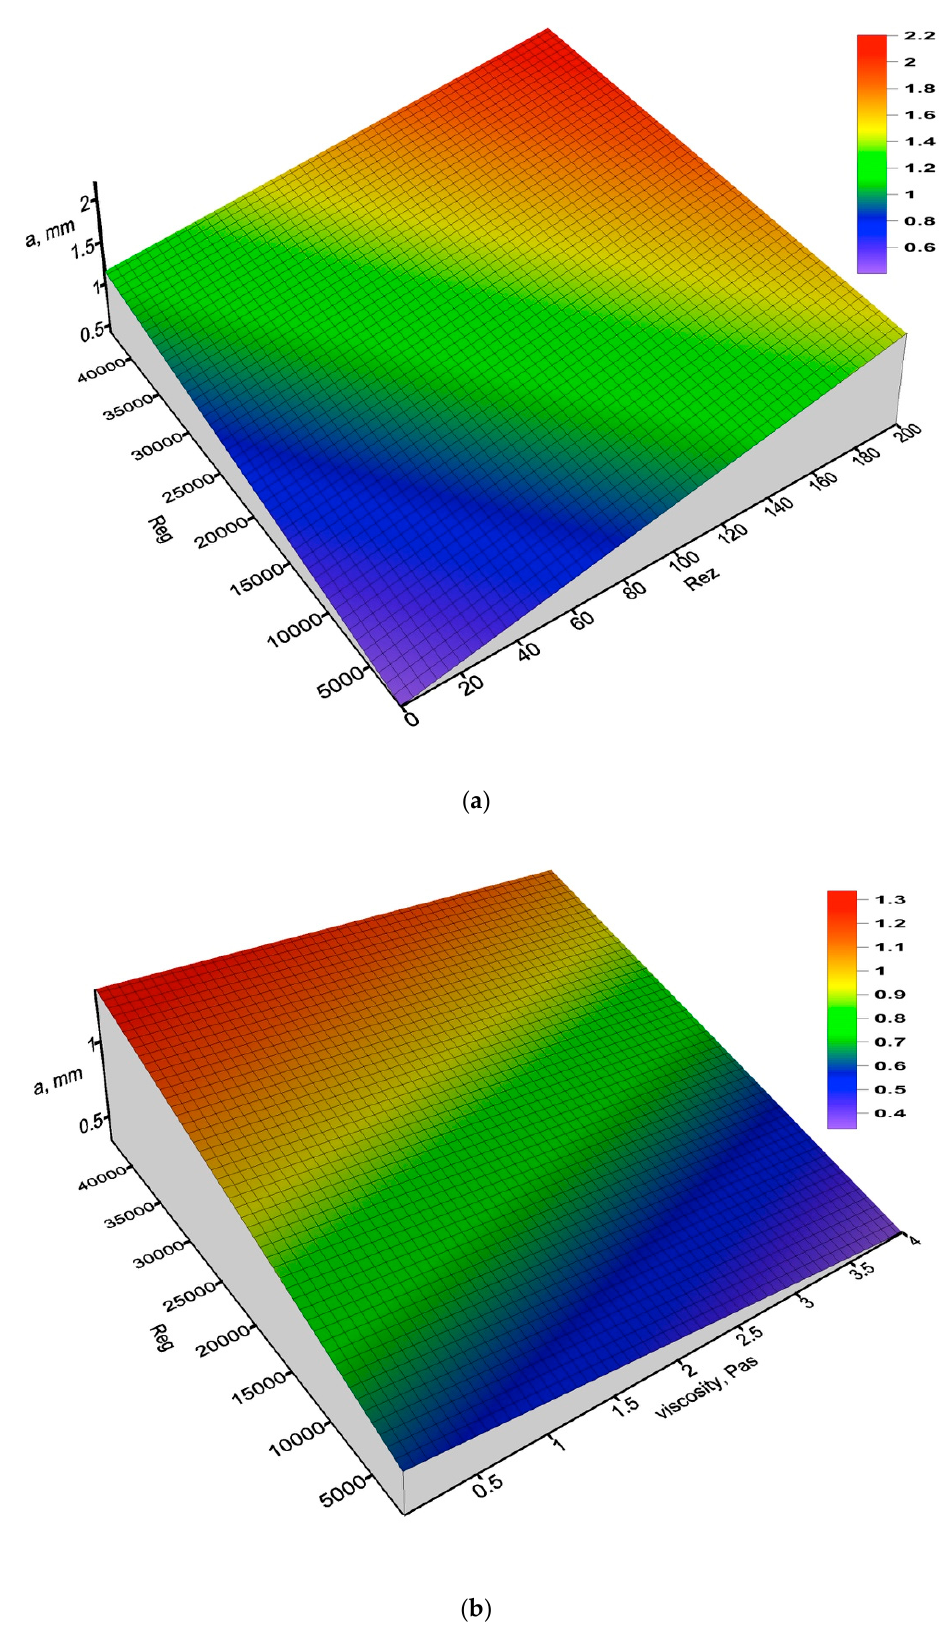
Figure 17. Results of calculations of wave amplitude accompanying two-phase gas-very viscous liquid flow for relation (17). (a) depending on Re z value; (b) depending on the viscosity value.